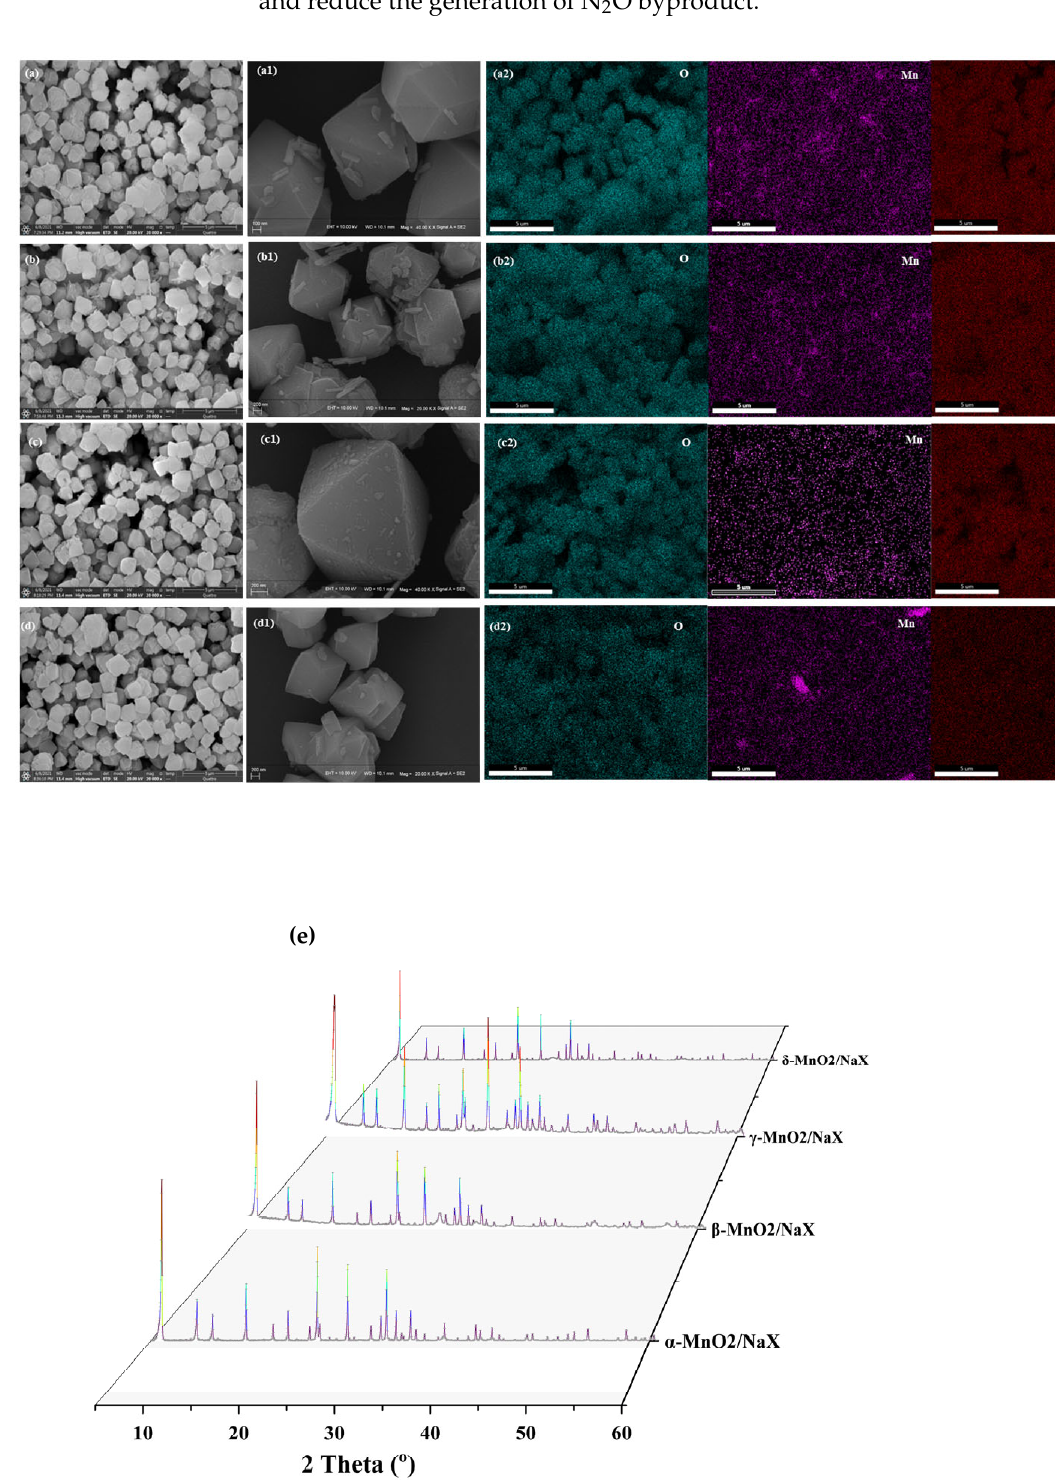
Figure 1. SEM images of ( a ), ( a1 ) α -MnO 2 /X, ( b ), ( b1 ) β -MnO 2 /X, ( c ), ( c1 ) γ -MnO 2 /X, and ( d ), ( d1 ) σ - MnO 2 /X catalysts, and element EDS mapping of ( a2 ) α -MnO 2 /X, ( b2 ) β -MnO 2 /X, ( c2 ) γ -MnO 2 /X, and ( d2 ) σ -MnO 2 /X catalysts; ( e ) XRD pattern of the catalysts.